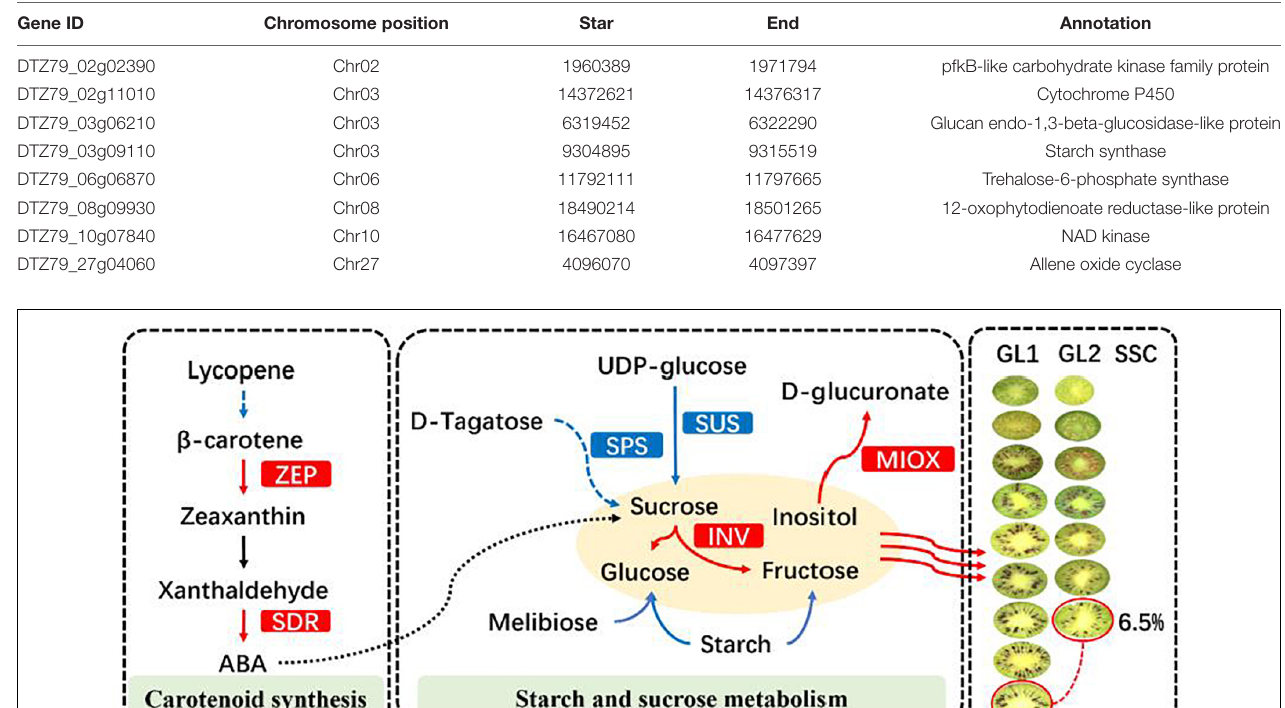
ABA was appeared at the early stage of fruit development and decreases with fruit maturity (Tao et al., 1994). The results